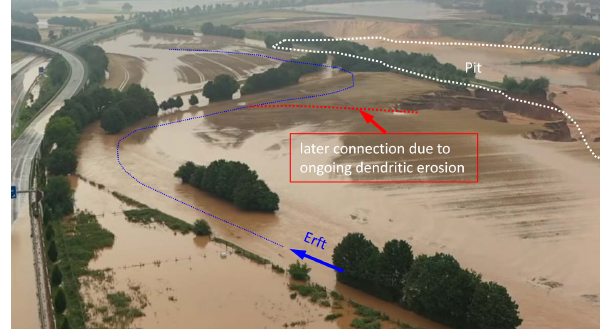
Figure 8. View of the pit Blessem (belongs to Erftstadt) during the flood with the location of the later connection of the river Erft to the pit (Maurice, 2021). Blue arrow shows the river flow direction.